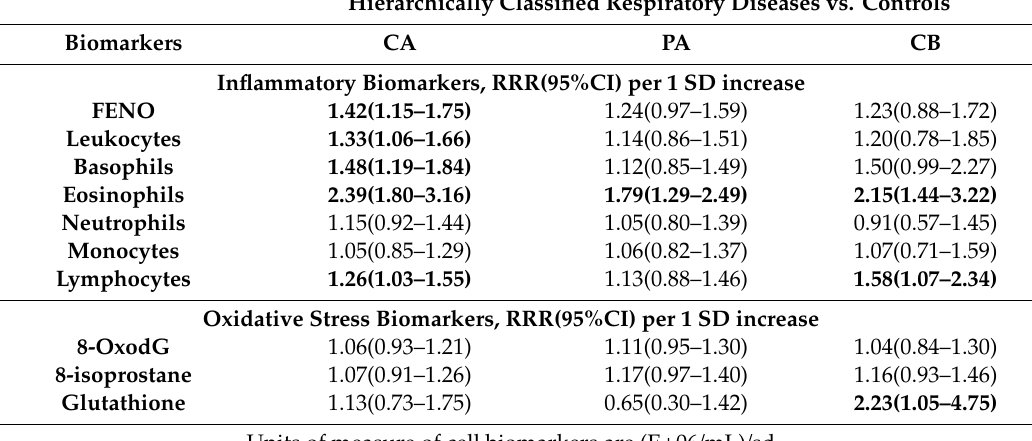
Table 2. Multivariable multinomial regression estimates of current asthma (CA), past asthma (PA) and chronic bronchitis (CB) in association with biomarkers.